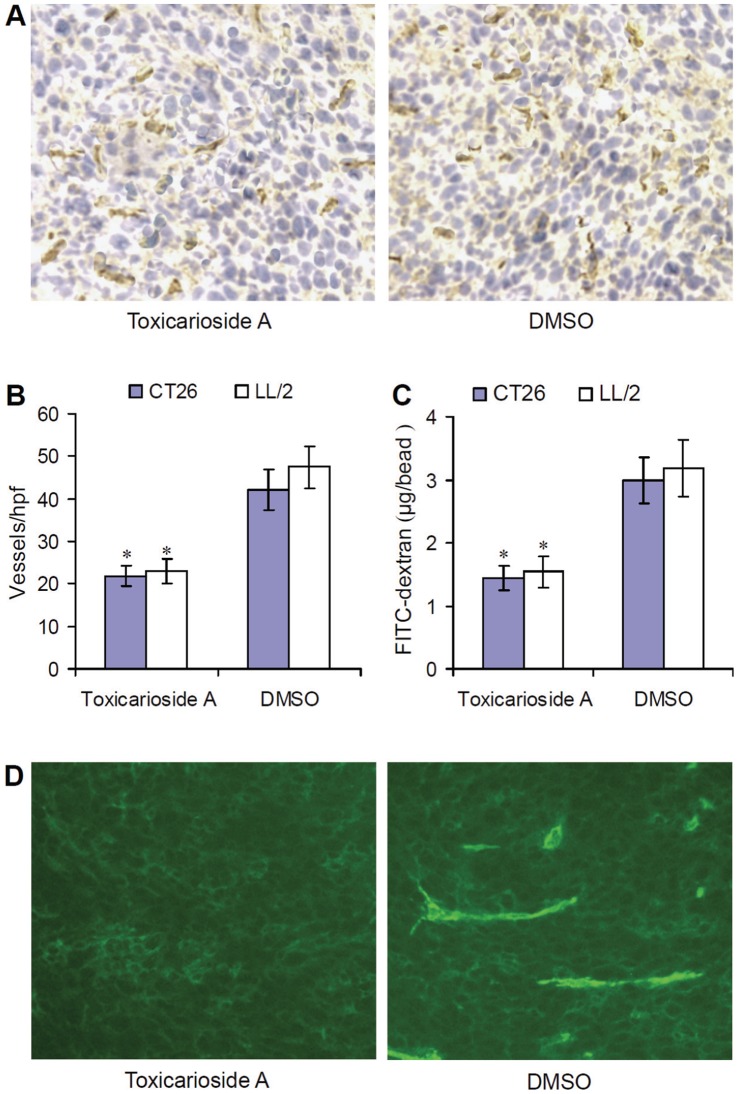
Inhibition of tumor angiogenesis and endoglin expression by toxicarioside A in vivo.(A) Frozen sections of tumor tissues were tested by immunohistochemical analysis with a monoclonal antibody against CD31 and the representative high-power field (hpf) in the sections under a microscope at 200× magnification. (B) The tumor vasculatures were quantified by counting the microvessels per hpf. (C) Quantitative analysis of the alginate implants. Alginate beads containing 1×105 tumor cells were implanted s.c. into the backs of mice. Mice were then treated with toxicarioside A or DMSO. Beads were surgically removed 14 days later and the FITC–dextran absorbed in the beads was quantified by a fluorescent ELISA reader. Data are expressed as means ± SEM, * P<0.001 or less, relative to the DMSO-treated group. (D) Shown are the representative images of endoglin expression in situ on the tumor vessels. Frozen sections of tumor tissues treated with toxicarioside A or DMSO were incubated with an antibody against endoglin and a second FITC-conjugated antibody was used to stain the sections. Slides were examined by a fluorescence microscopy at 200× magnification.